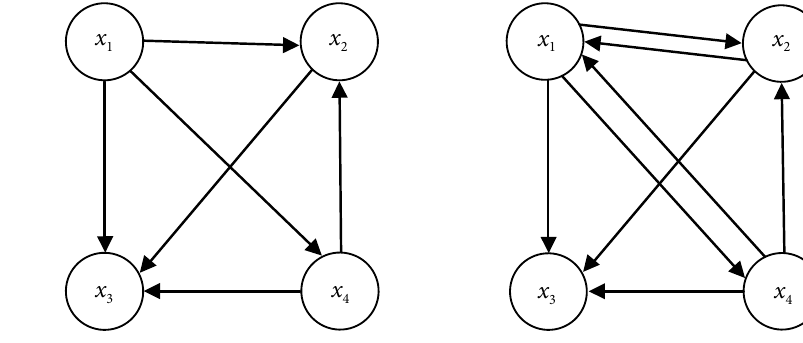
Fig. 1. Hesitant fuzzy preference graph of